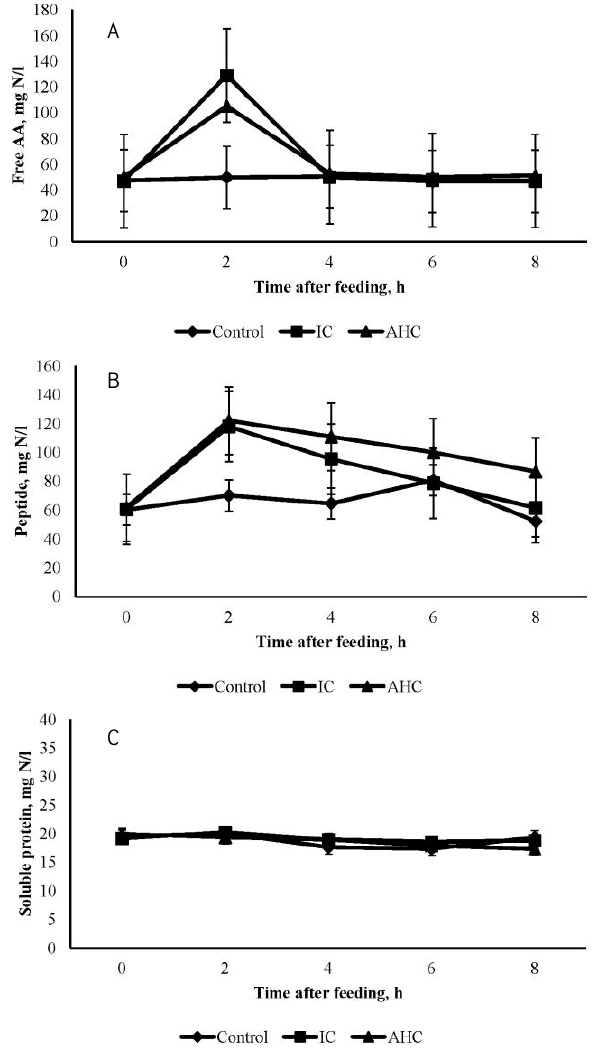
Figure 1. Diurnal pattern in concentration of free amino acids (AA) (A), peptide (B) and soluble protein (C) in the liquid phase of ruminal digesta (RD) during a feeding cycle as influenced by soluble protein supplements (Markers indicate no supplement (  ), intact casein (■) and acid hydrolyzed casein (▲), respectively).